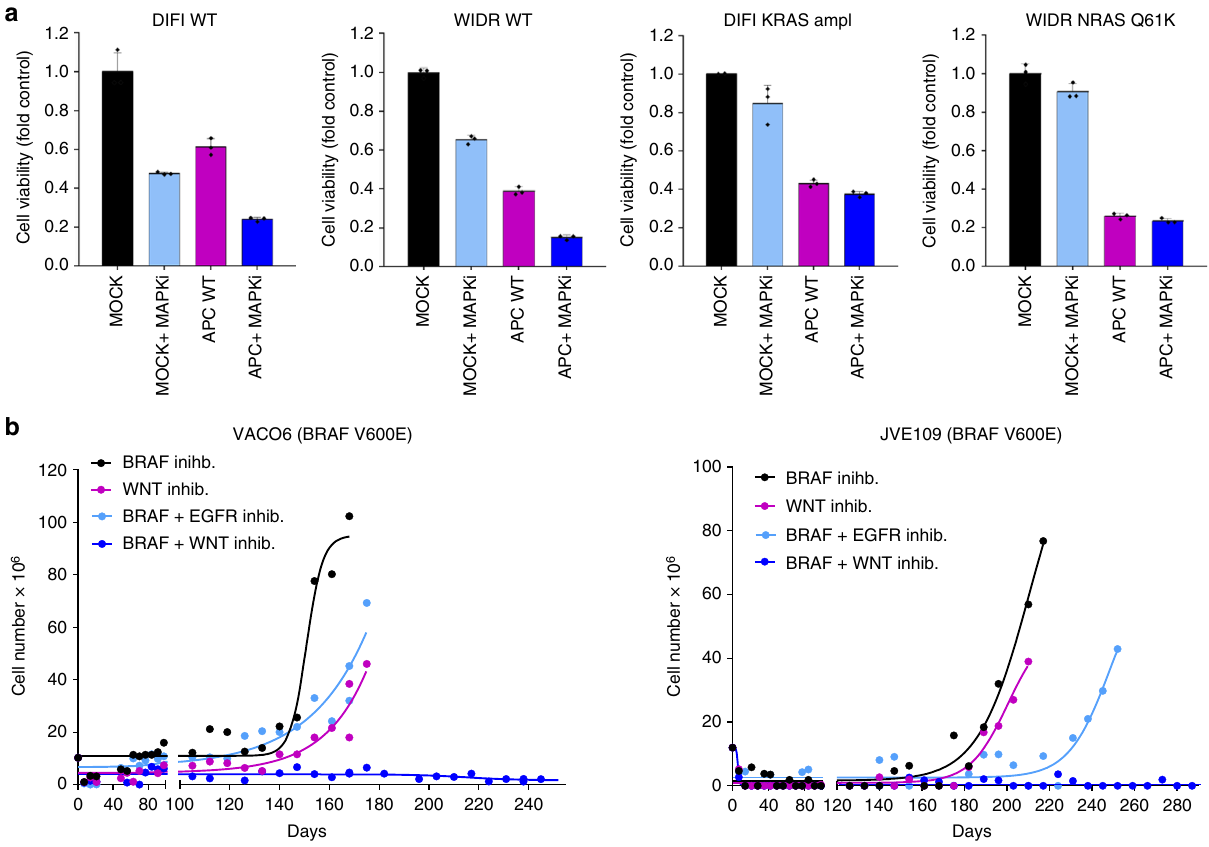
Fig. 7 Concomitant blockade of WNT and MAPK signalling restricts the emergence of drug resistance. a APC-mutated CRC cells and their MAPK-resistant derivatives were transfected with plasmid expressing intact WT APC or control electroporation buffer (mock). After transfection, the cells were seeded in 48-wells plates with or without cetuximab (DIFI cells), dabrafenib + cetuximab (WIDR cells). After 48 h, cell viability was assayed by ATP assay. Representative graphs of two independent experiments for each cell line are reported. Results represent means ± SD of three independent wells. Single points indicate results of single experiments. b BRAF-mutated CRC cells were treated with dabrafenib (BRAFinhib.), dabrafenib + cetuximab (EGFRinhib.), LGK974 (WNTinhib.), or dabrafenib + LGK974, until secondary resistance